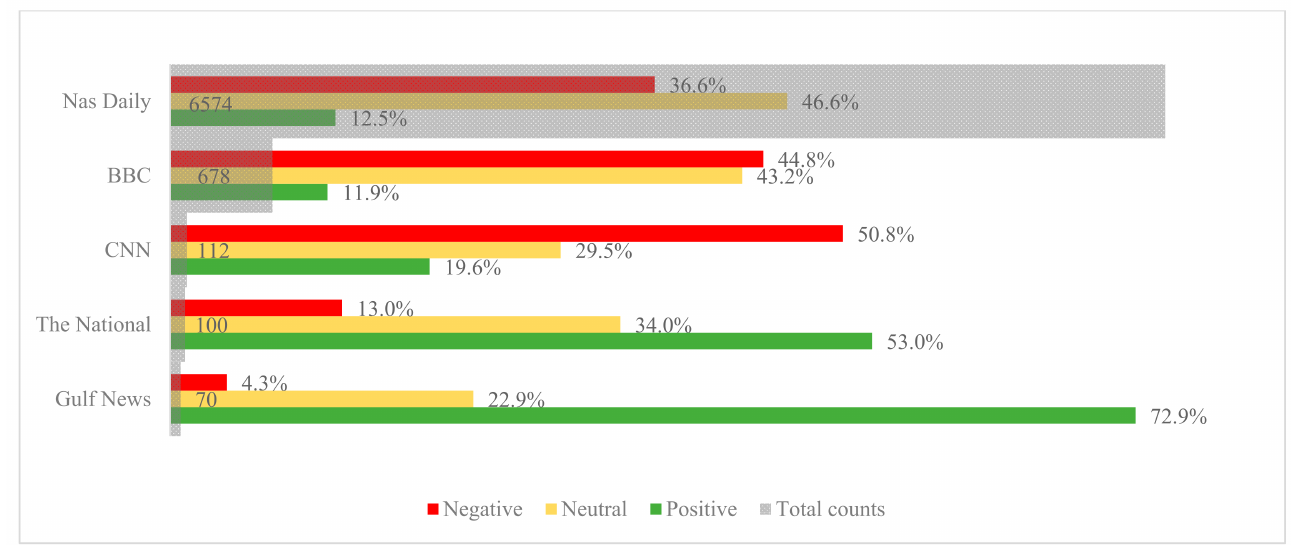
Figure 3. Sentiment analysis results (counts and